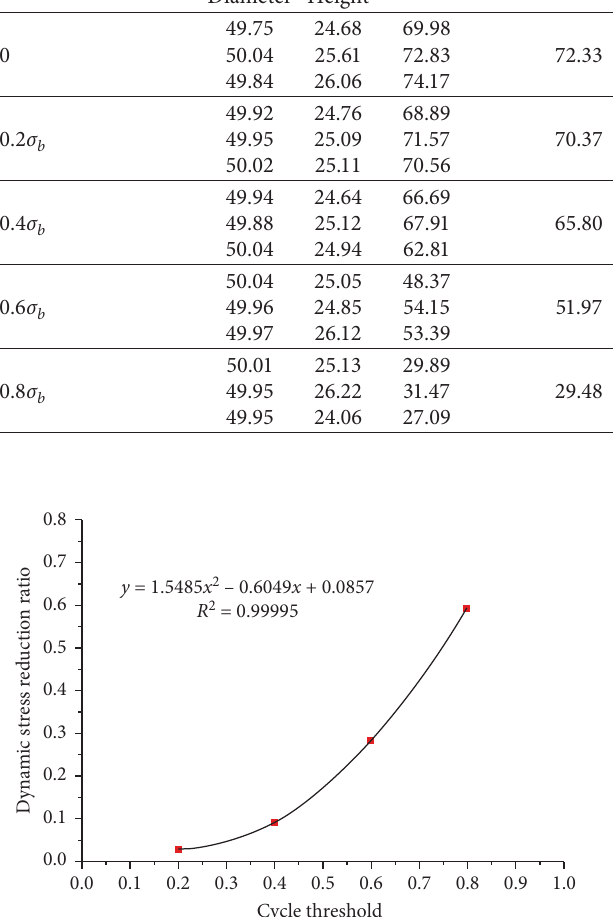
Table 2: Energy statistics of sandstones with different degrees of damage under impact load. Cyclic load threshold